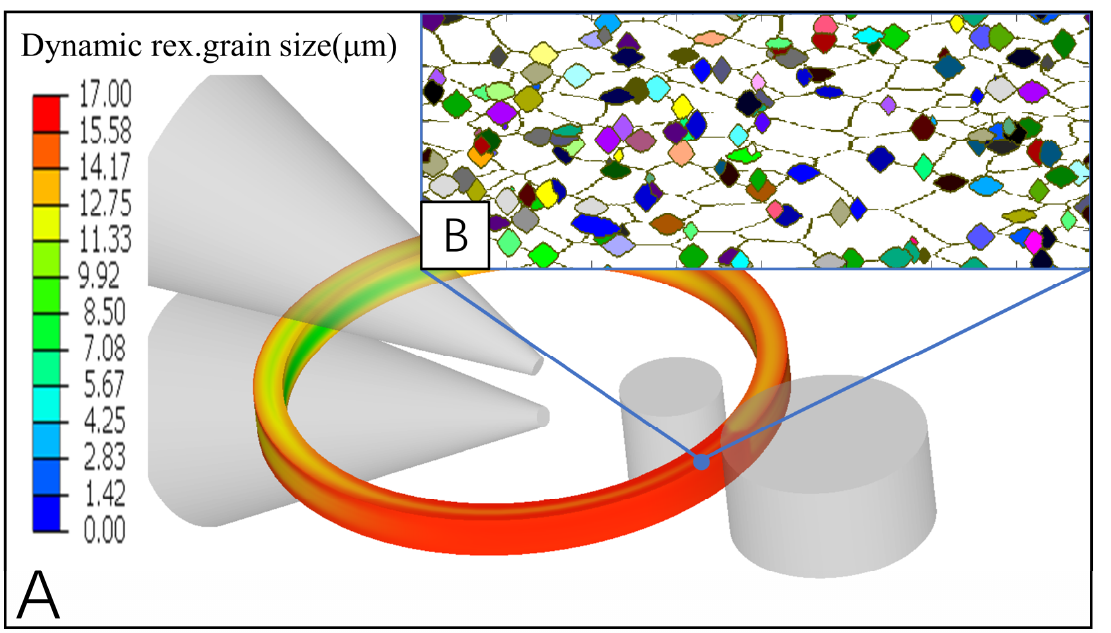
Figure 12. ( A ) Distribution of DRX grain size under FEM ( B ) Distribution of DRX grain size under CA at reference point.